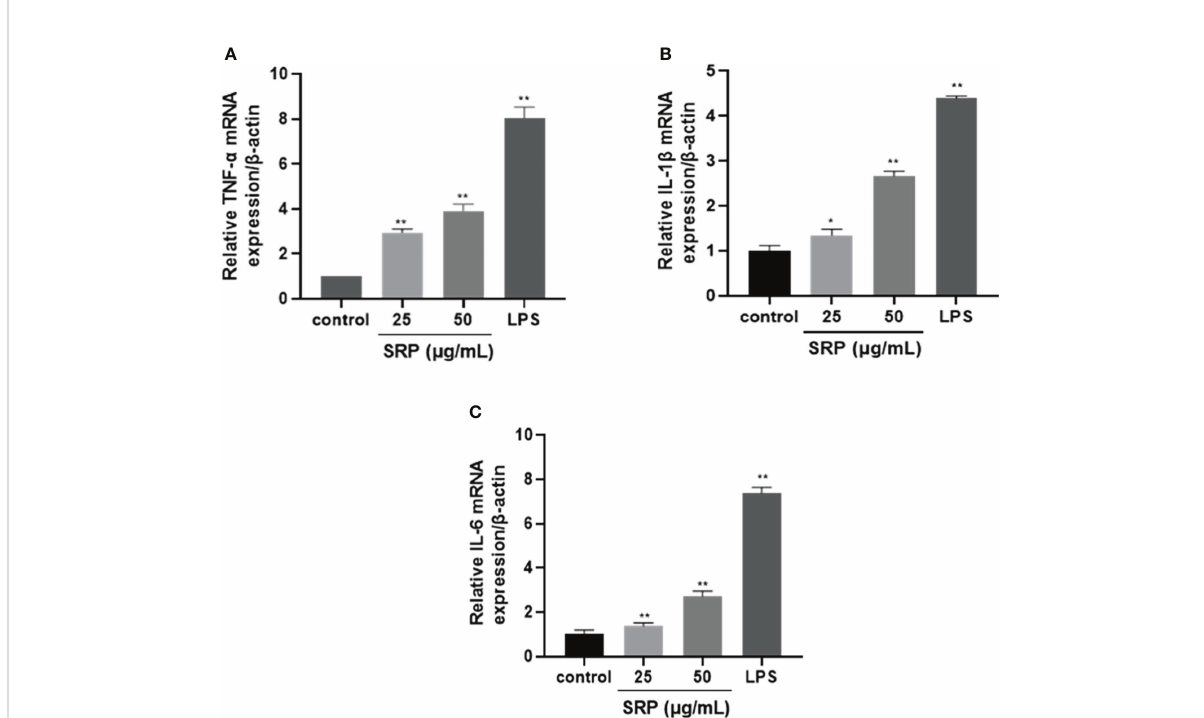
FIGURE 6 Effects of SRP on the expression of cytokine genes in RAW264.7 macrophages. (A-C) Expression of TNF- a , IL-1 b and IL-6 mRNA. Signi fi cant differences with the control group: * p < 0.05 and ** p <